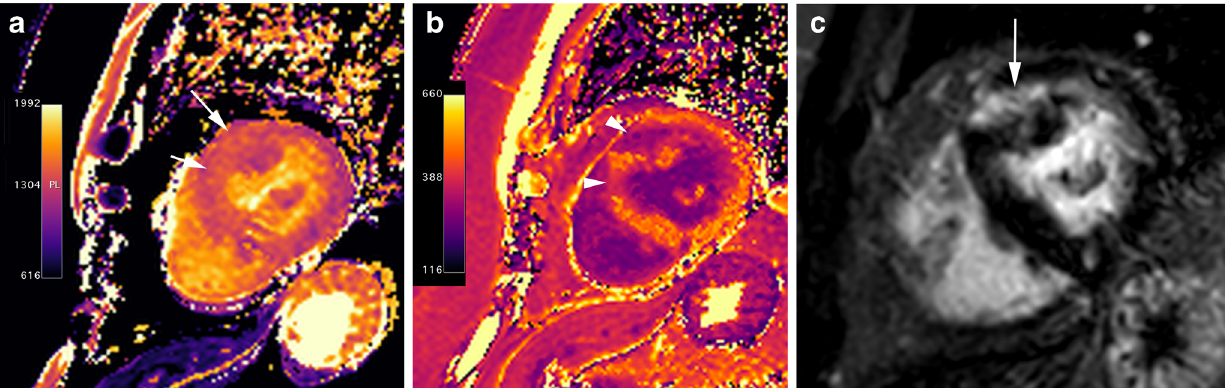
Fig. 9 T1 mapping in a 67-year-old woman with basal anterior and anteroseptal HCM. a , Short-axis nonenhanced MOLLI (1.5 T) T1 map shows prolonged T1 values in the area of myocardial hypertrophy (ar- rows). b , T1 map obtained at LGE MR imaging shows abnormal short- ening of the T1 values in the hypertrophied segments (arrowheads). The